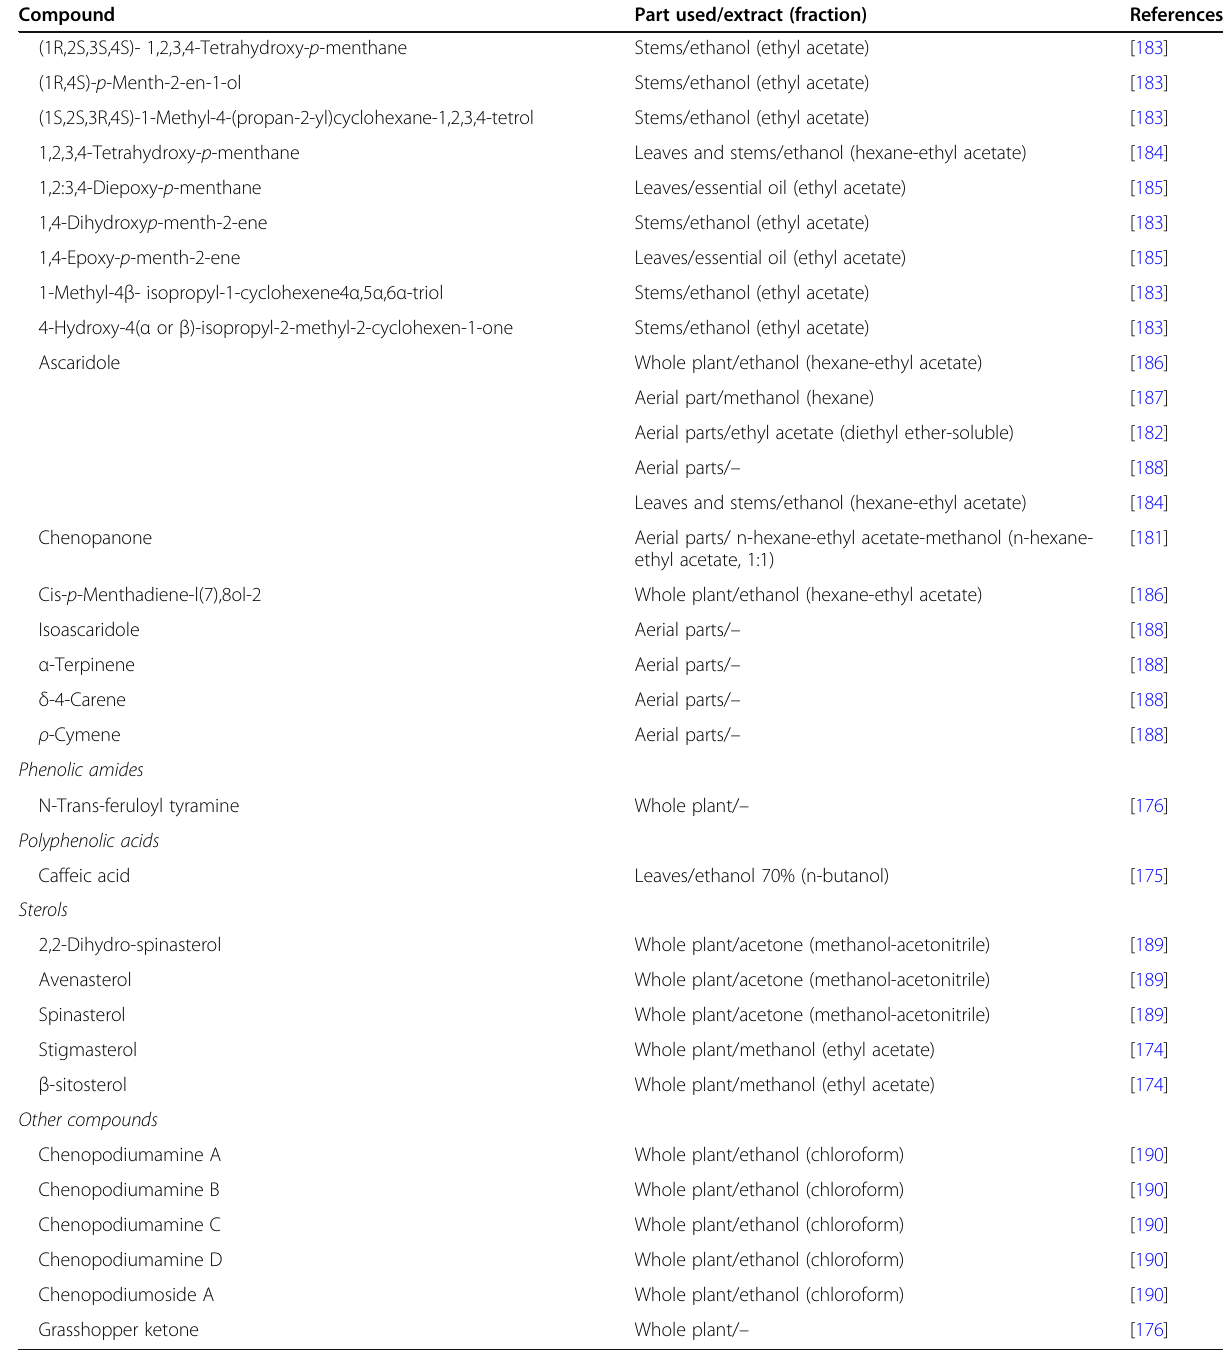
Table 2 Secondary metabolites isolated from C. ambrosioides (Continued)